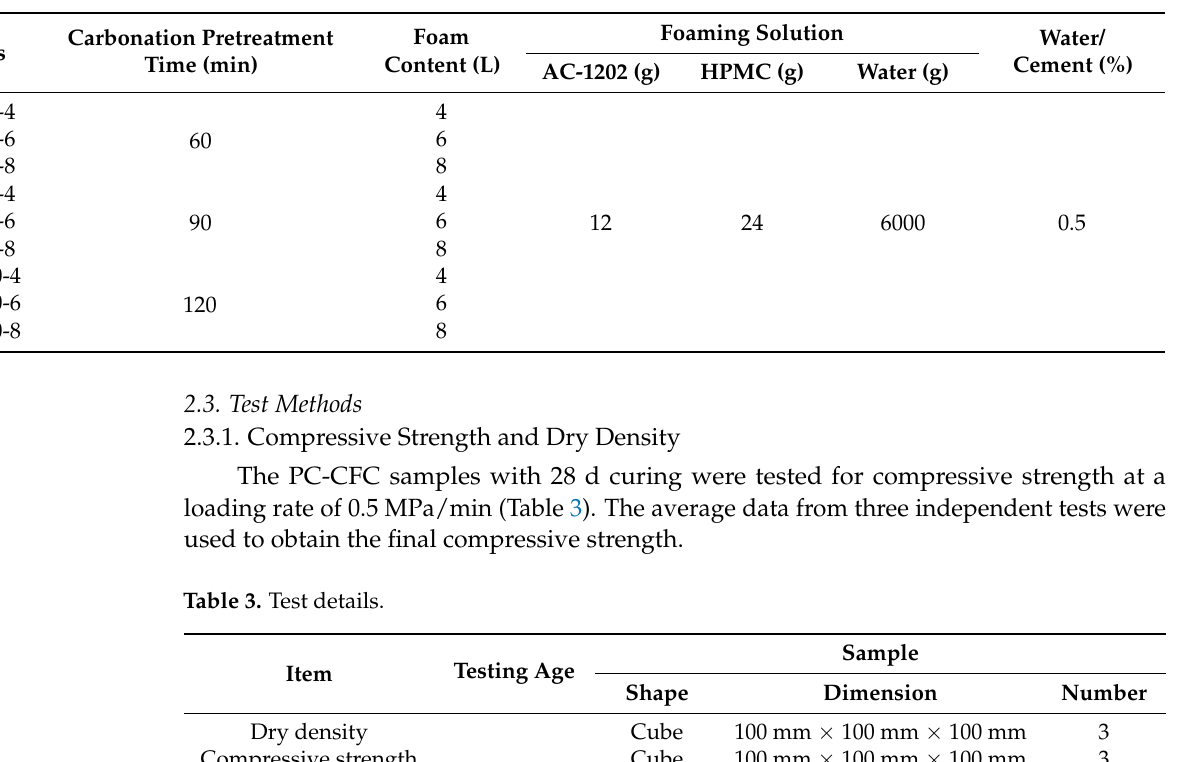
Table 2. Mixing compositions of Portland-cement-based CO 2 foam concrete